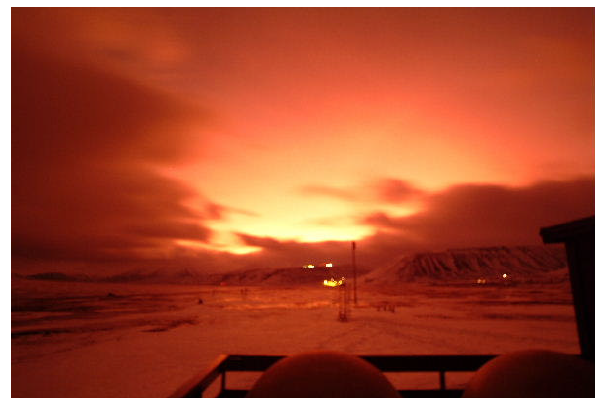
Fig. 1. Photograph of the event taken from the Auroral Station in Adventdalen, Svalbard, Norway, at 08:42:41 UT on 6 December Figure 1. Photograph of the event taken from the Auroral Station in Adventdalen, 2002. The exposure time is 20s at F/2.8, using a 14–mm lens with Svalbard, Norway, at 08:42:41 UT 06.12.2002. The exposure time is 20 second at a Fujifilm S2Pro camera body. The sensitivity is ISO F/2.8 using a 14 mm lens with a Fujifilm S2Pro camera body. The sensitivity is ISO 200.